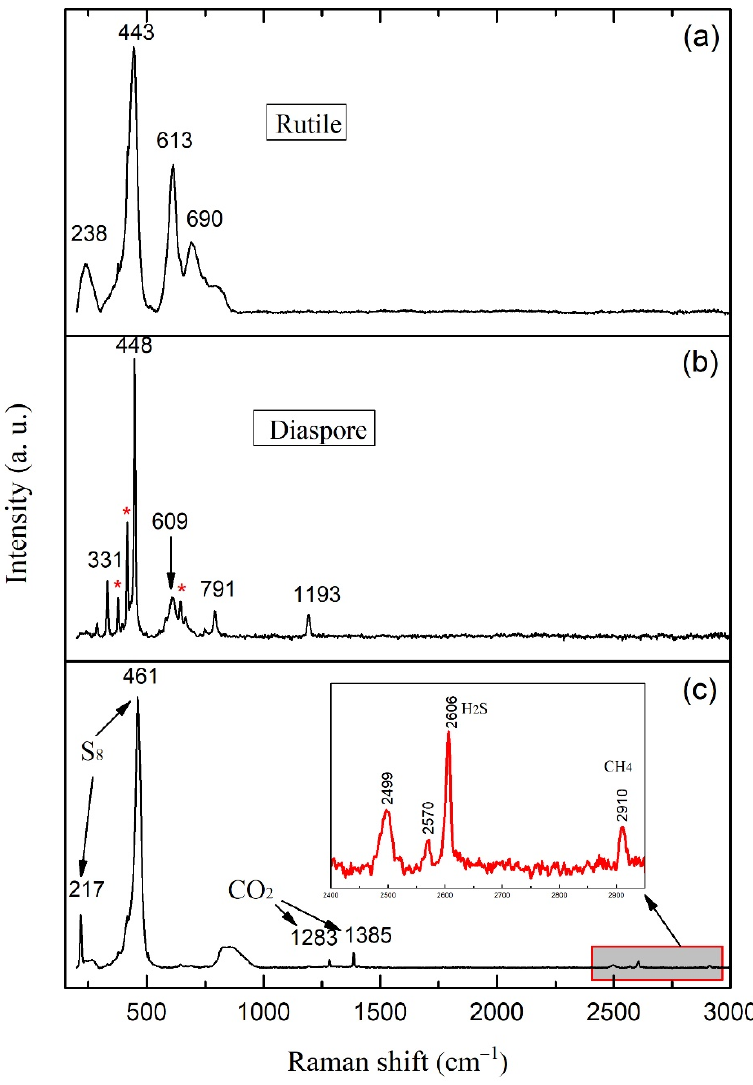
Figure 5. Raman spectra of the fluid inclusion as shown in Figure 4a: ( a ) the Raman spectrum corresponds to rutile; ( b ) Raman spectra showed that the transparent crystal was diaspore. Asterisk denoted the Raman signals from the hosting corundum; ( c ) the components of the included fluid included native sulfur (S 8 ), CO 2 , H 2 S, and CH 4 . Two bands centered at 2499 and 2570 cm –1 can be clearly seen.